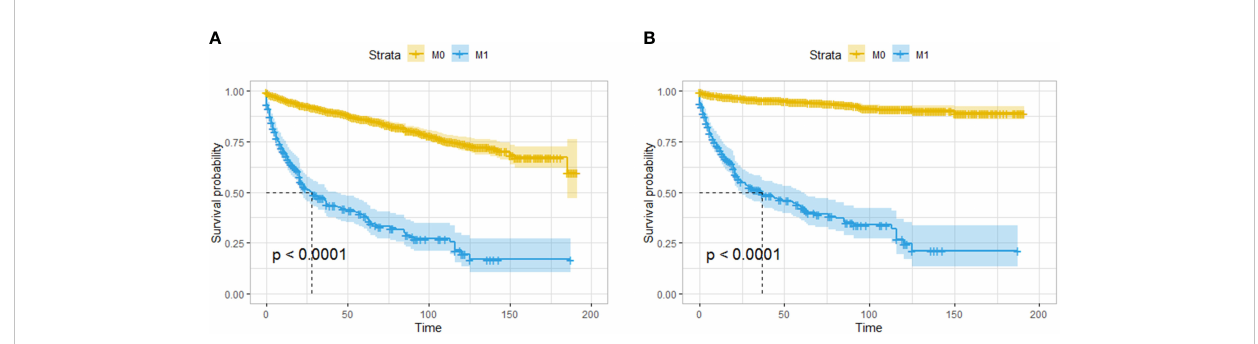
FIGURE 6 Survival analysis based on the state of distant invasion of the tumor: OS (A) and CSS (B) of all the patients. The patients with distant metastasis had worse OS and CSS than those without distant metastasis.